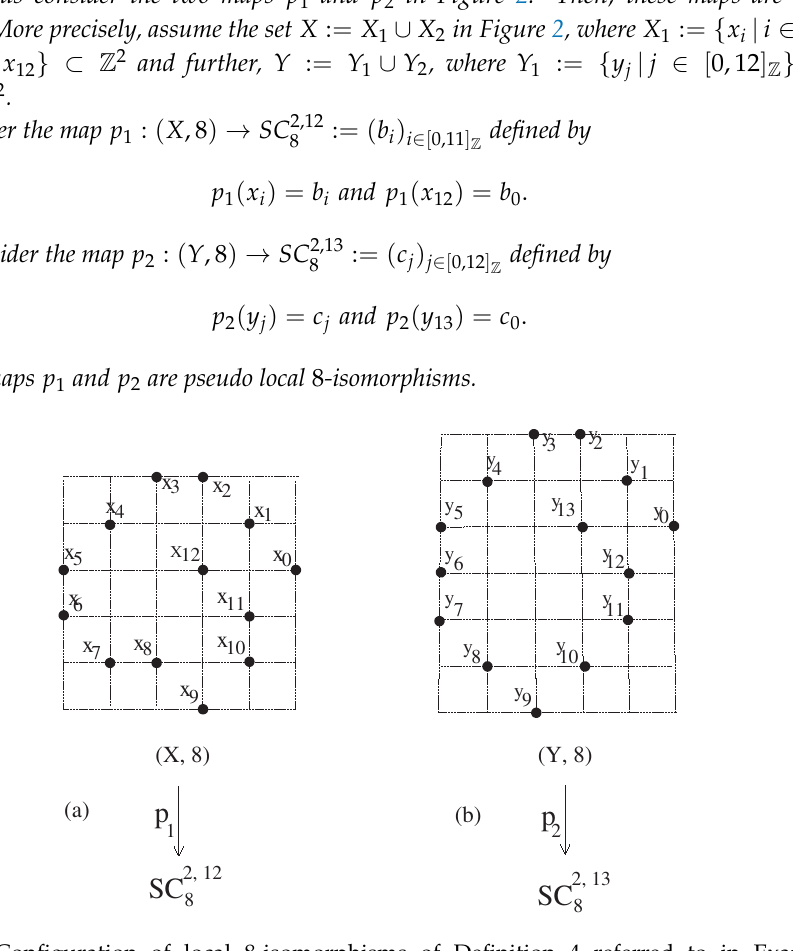
Figure 2. Configuration of local 8-isomorphisms of Definition 4 referred to in Example